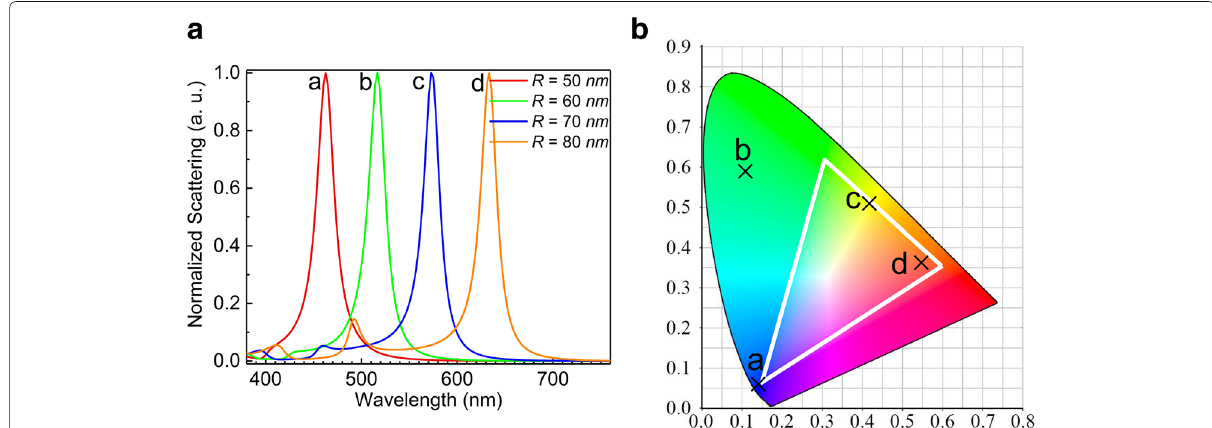
Fig. 5 a Normalized scattering spectra calculated for Si NSs with different radii placed on a 50-nm-thick Au film. b Color indices derived from the scattering spectra shown in